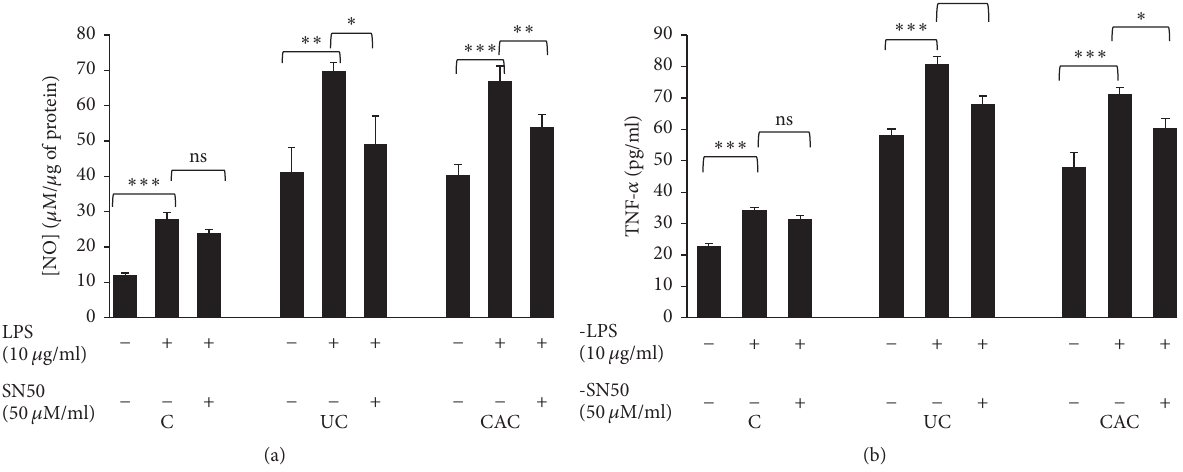
Figure 10: Role of NF- 𝜅 B signaling on nitric oxide (a) and TNF- 𝛼 (b) production by colonic mucosa stimulated with LPS (10 𝜇 g/ml) in UC and CAC patients. Values represent mean ± standard deviation. Significance compared with control: ∗∗∗ 𝑃 < 0.001 , ∗∗ 𝑃 < 0.01 , and ∗ 𝑃 < 0.05 ; ns: no significant difference (UC: ulcerative colitis; CAC: colitis associated cancer; C: control, normal